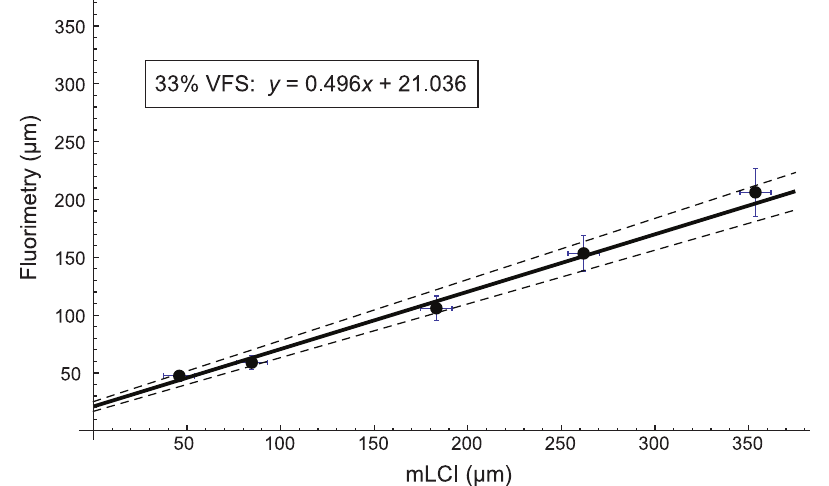
Figure 2. Gel thickness measurements of 33% VFS dilution of FACTS-001 gel with vaginal fluid simulant in the calibration socket as measured by fluorimetry (y-axis) and mLCI (x-axis). A refractive index value of 1.4 (Table 1) was used to calculate mLCI thickness. Line of best fit was found using a weighted least-squares algorithm. The 95% confidence interval for the fitted line is provided by the dashed lines.